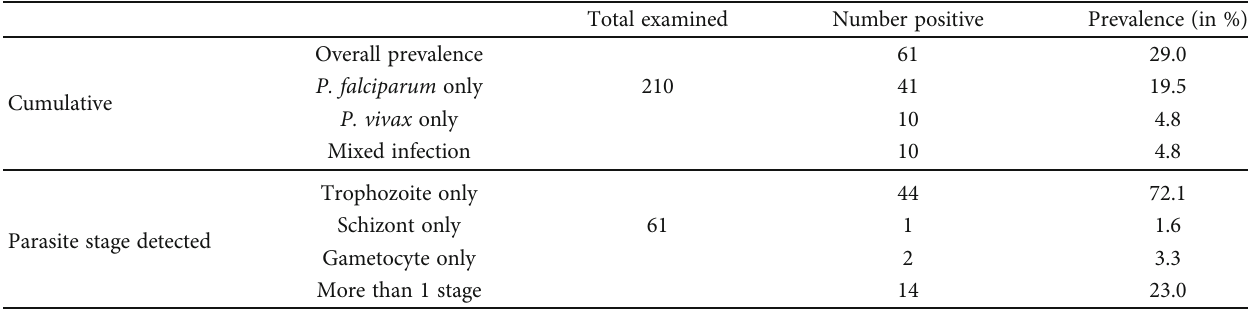
Table 4: Prevalence of malaria parasites among febrile patients attending Hamusit Health Center, Northwest Ethiopia, from February to March